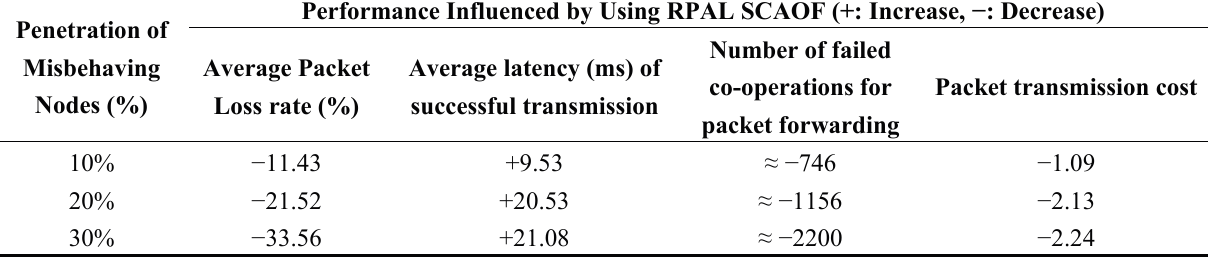
Table 9. Simulation results of 30 LLN nodes with node state runtime reconfiguration. Penetration of